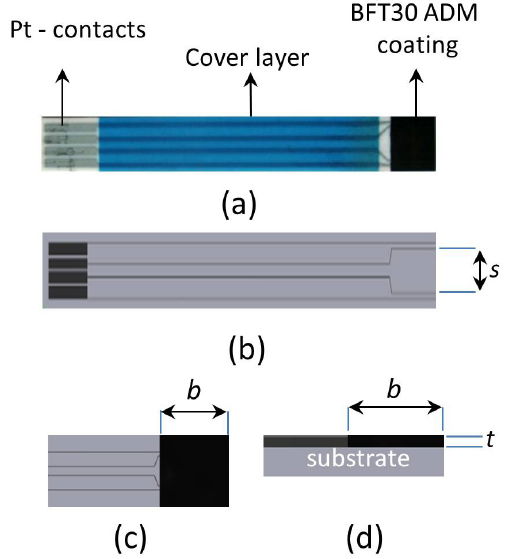
Figure 1. Sketch of the sensor setup, (a) top view of sensor showing Pt contacts, cover layer and BFT30 ADM coating, (b) , (c) and (d) indicating the dimension for the calculation of the